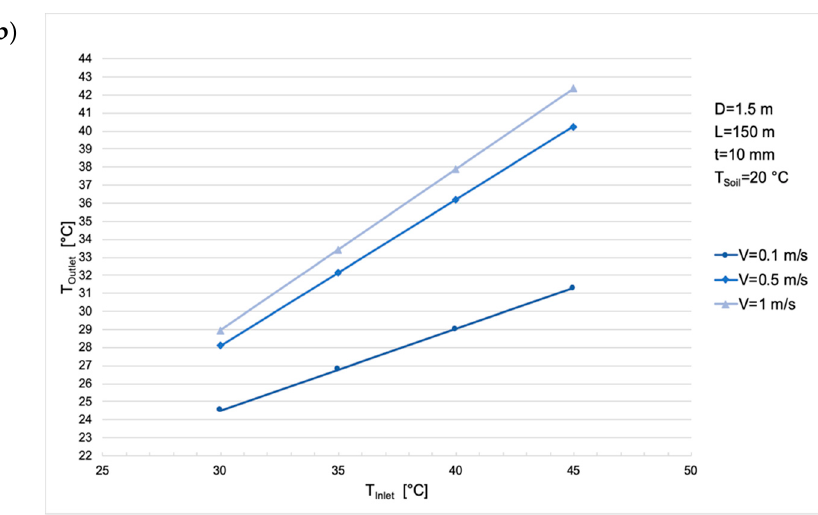
Figure 6. Variation of the outlet air temperature with distance between three pipes (panel a) and with inlet air temperature (panel b).